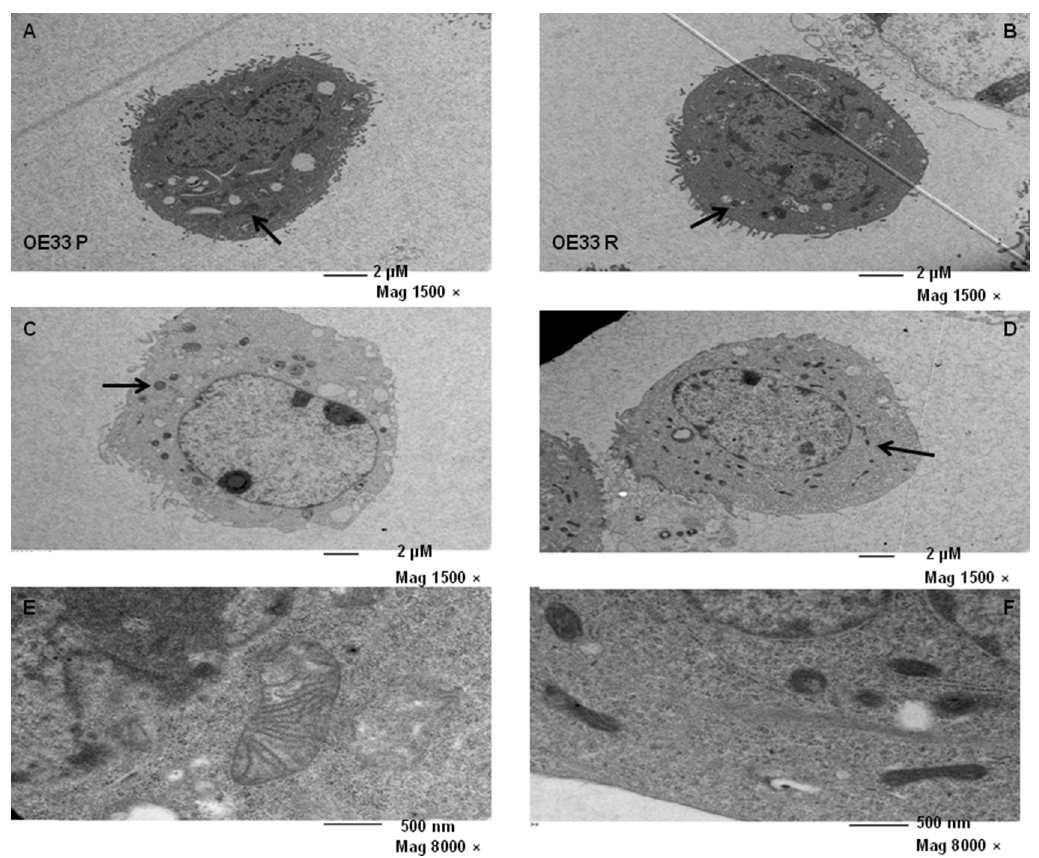
Figure 2. OE33 R cells have increased basal numbers of mitochondria and display altered morphology. The ultrastructure of OE33 P (A, C and E) and OE33 R cells (B, D and F) was assessed basally (A, B, E, F) and at 24 h post 2 Gy (C and D) by TEM. Representative images are shown. Black arrows point to mitochondria.